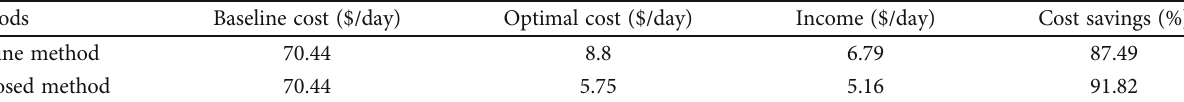
Table 3: Daily optimal cost and saving comparison.